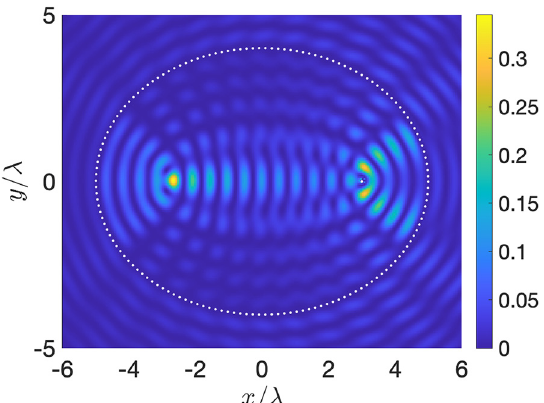
Figure 6: Total field intensity ( atoms (marked by white dots) placed along the circumference of an ellipse, and one atom at the positive focus of the ellipse. The incident wave is taken to be ϕ